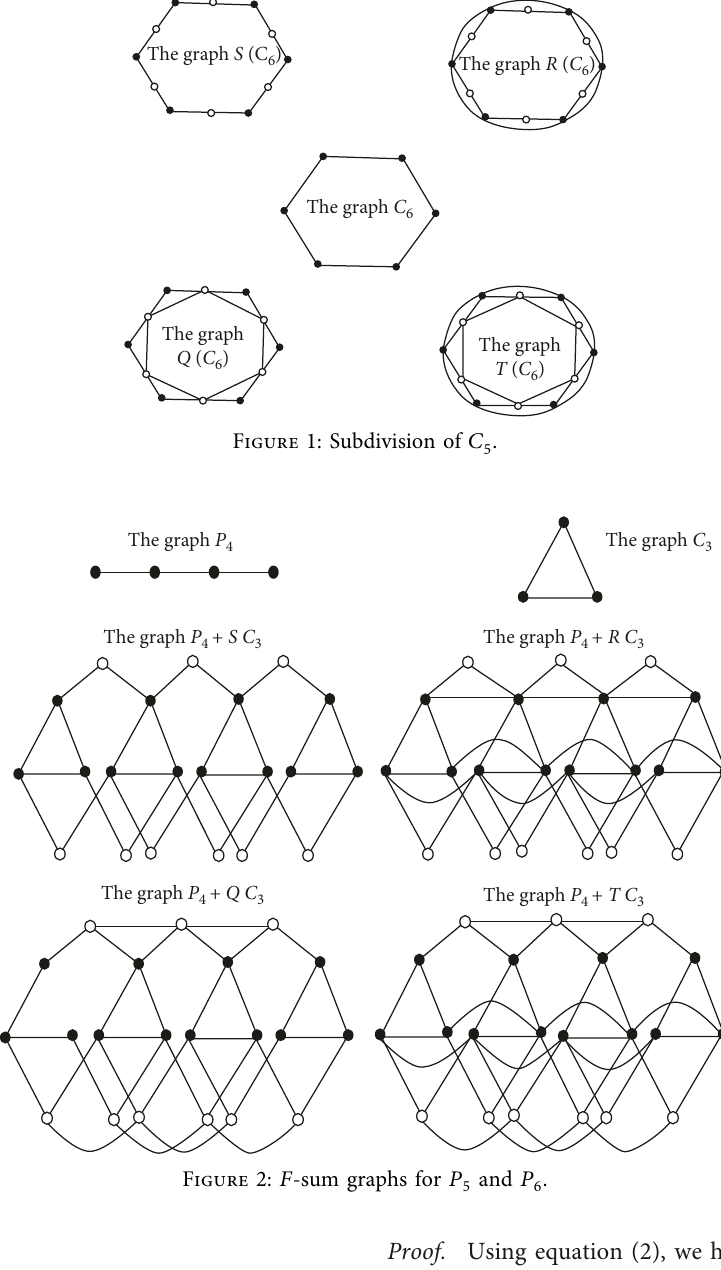
Figure 2: F -sum graphs for P